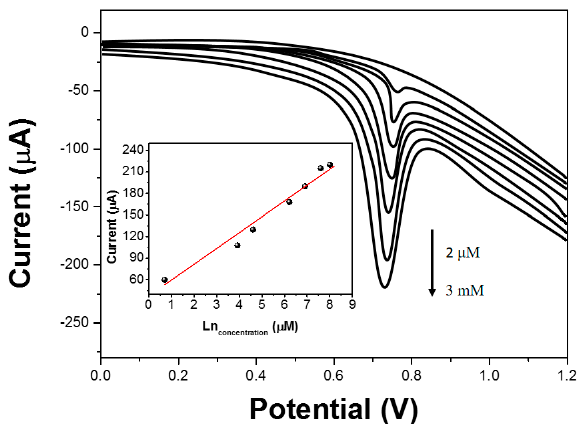
Figure 6. Linear sweep adsorptive stripping voltammograms and their associated calibration plot (insert) with increasing concentrations of MT at GNs/HA/GCE under optimum conditions.